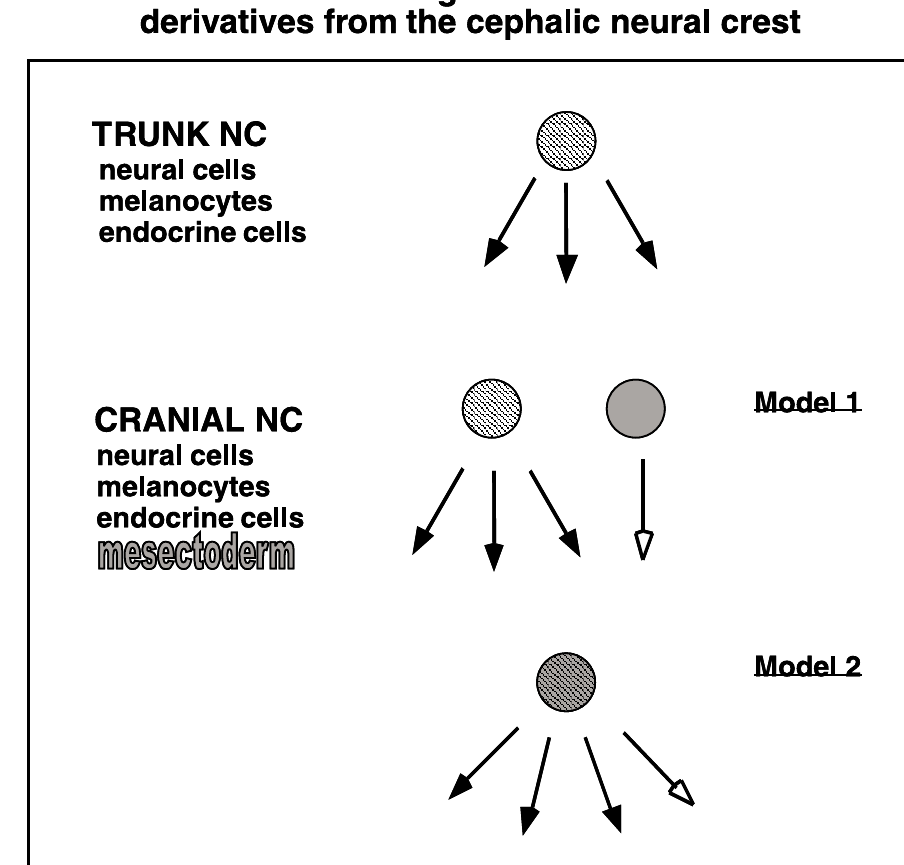
Fig. 1 – Models for the origin of mesectodermal derivatives from the cephalic NC. Cranial and trunk NC share common derivatives (neural cells, melanocytes and endocrine cells) which derive from a multipotent NC stem cell in the trunk ( striped circle ). In addition to these trunk-like derivatives, the cephalic NC yields the mesectoderm. Two models can be proposed : Either the mesectoderm is generated from a specific precursor ( grey circle ) which is segregated early from trunk-like multipotent NC cells ( striped circle ) (Model 1) ; The other possibility is that common precursors ( striped grey circle ) are endowed with all cephalic NC potentialities, including the ability to yield mesectodermal derivatives (Model